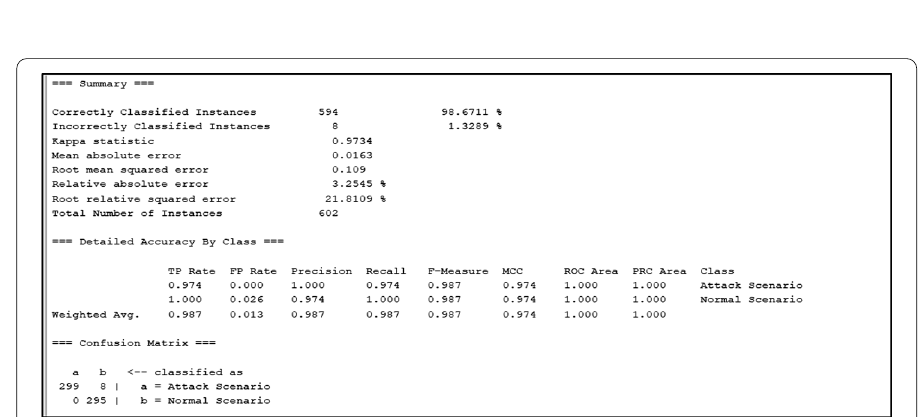
Fig. 8 Detailed Accuracy applying Cross Validation using Naive Bayes Machine Learning